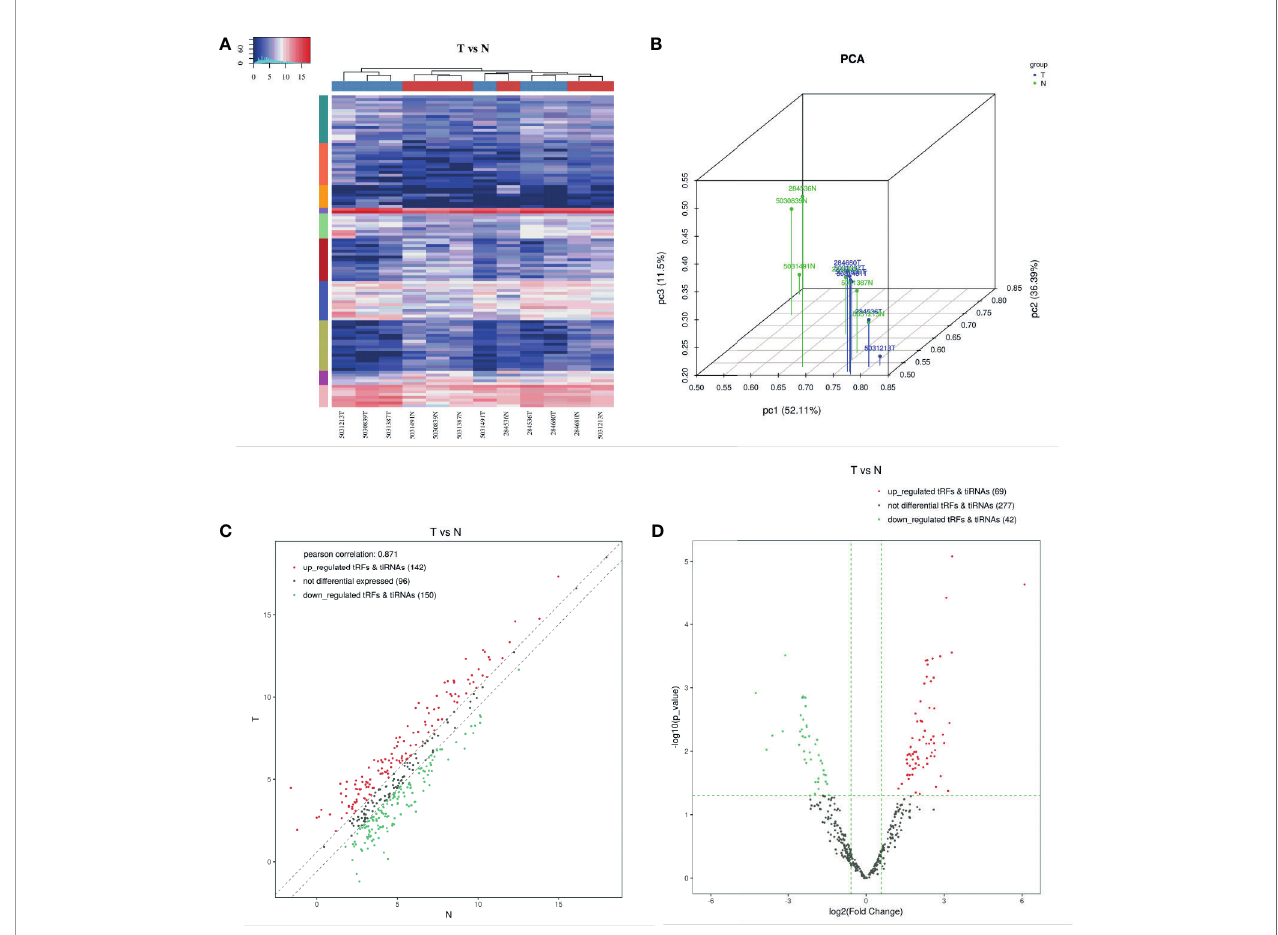
FIGURE 1 | Expression Pro fi les of tRNA-derived Fragments. (A) The hierarchical clustering heatmap for tRF & tiRNA. In this heatmap, the upper color bar represents the group classi fi cation of gastric cancer tissues and NATs. The left color bar of the panel represents the cluster analysis of differentially expressed tsRNAs based on K-means. Generally, red indicates the high expression level, and blue indicates the low expression level. (B) Primary component analysis. The result of PCA analysis shows a distinguishable tRF & tiRNA expression pro fi ling among the GC and NATs samples. The fi gure is an overview of samples correlations. (C) The scatter plot between two groups for tRF & tiRNA. 142 up-regulated tRFs & tiRNAs, 150 down-regulated tRFs & tiRNAs, and 96 not differential expressed tRFs & tiRNAs were screened out. The Pearson correlation between GC and NATs was 0.871. (D) The volcano plot of tRF & tiRNA. The volcano plot is based on CPM values of tsRNAs, and we found that 69 up-regulated tRFs & tiRNAs, 42 down-regulated tRFs & tiRNAs, and 277 not differential tRFs & tiRNAs were